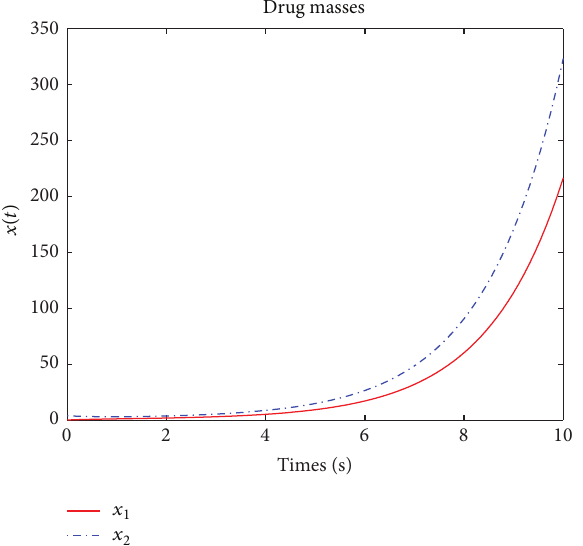
Figure 1: Time response of the biochemical network under 𝑢 = 0 .